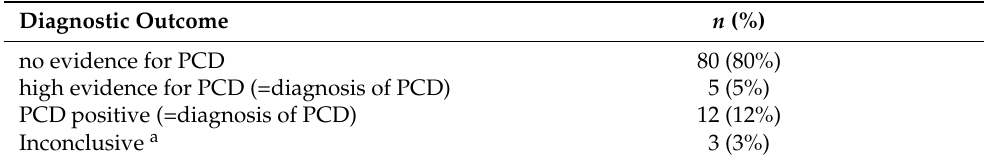
Table 2. Diagnostic outcome of the first 100 patients referred to PCD-UNIBE. Diagnostic